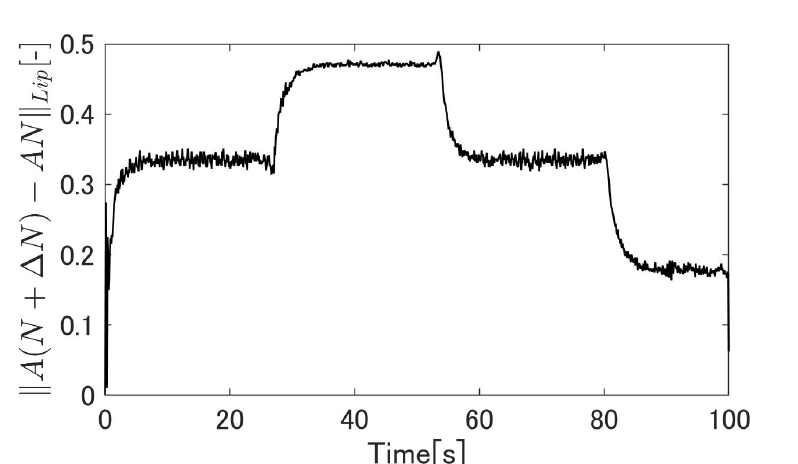
Figure 28. The robust stability